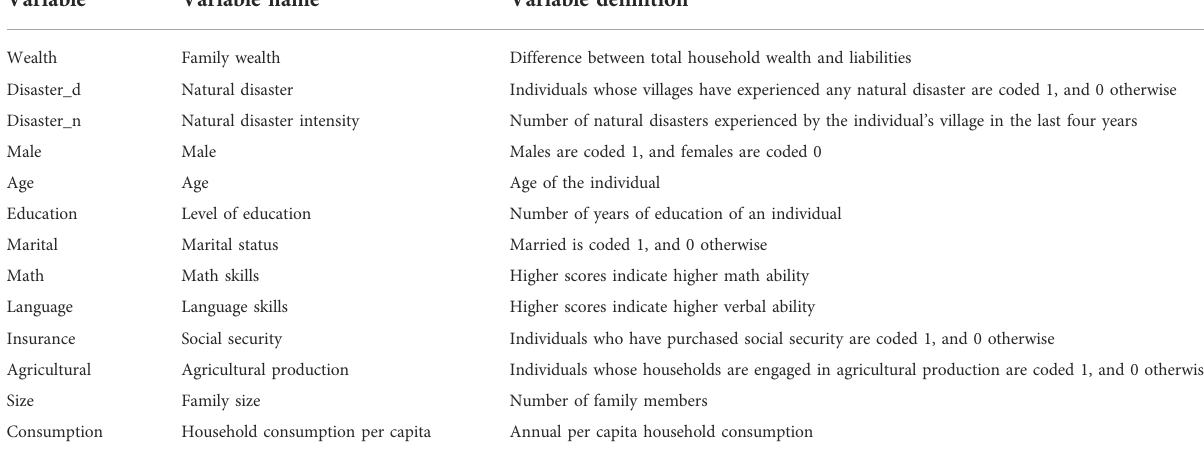
TABLE 1 Variable de fi